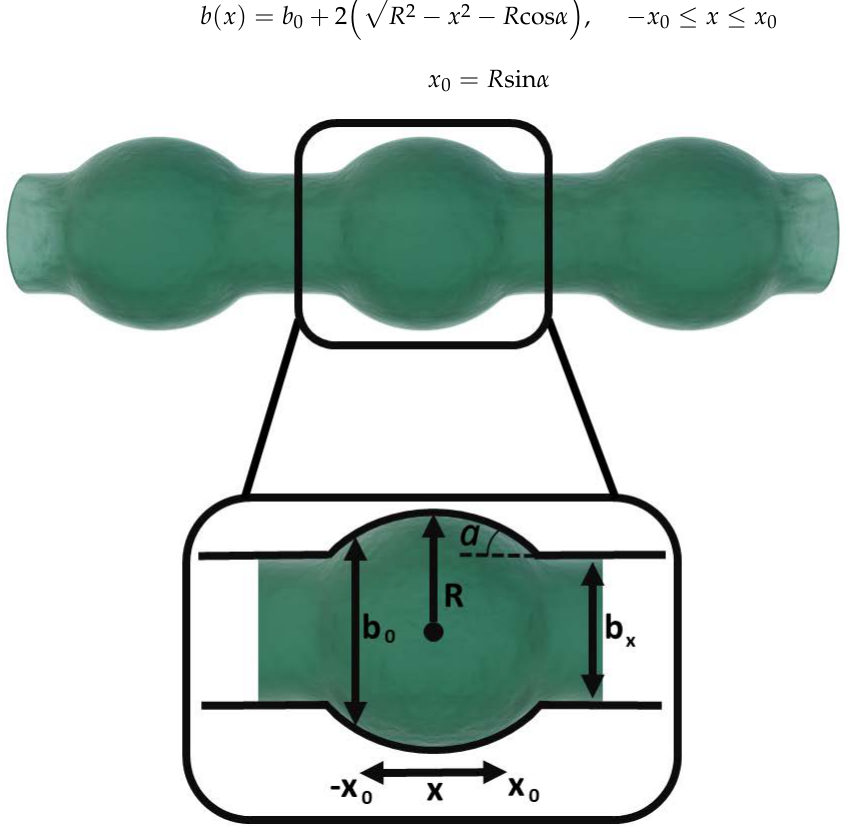
Figure 3. A bulge in the middle of a stable line with a constant width b0 (inspired from